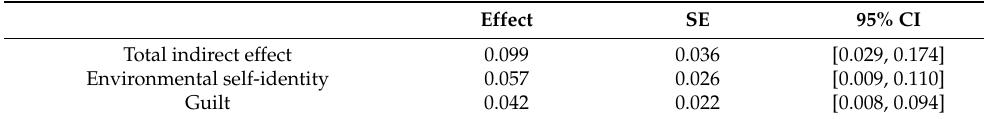
Table 5. Indirect effect of regulatory policy on sustainable consumption behaviour through environ- mental self-identity and